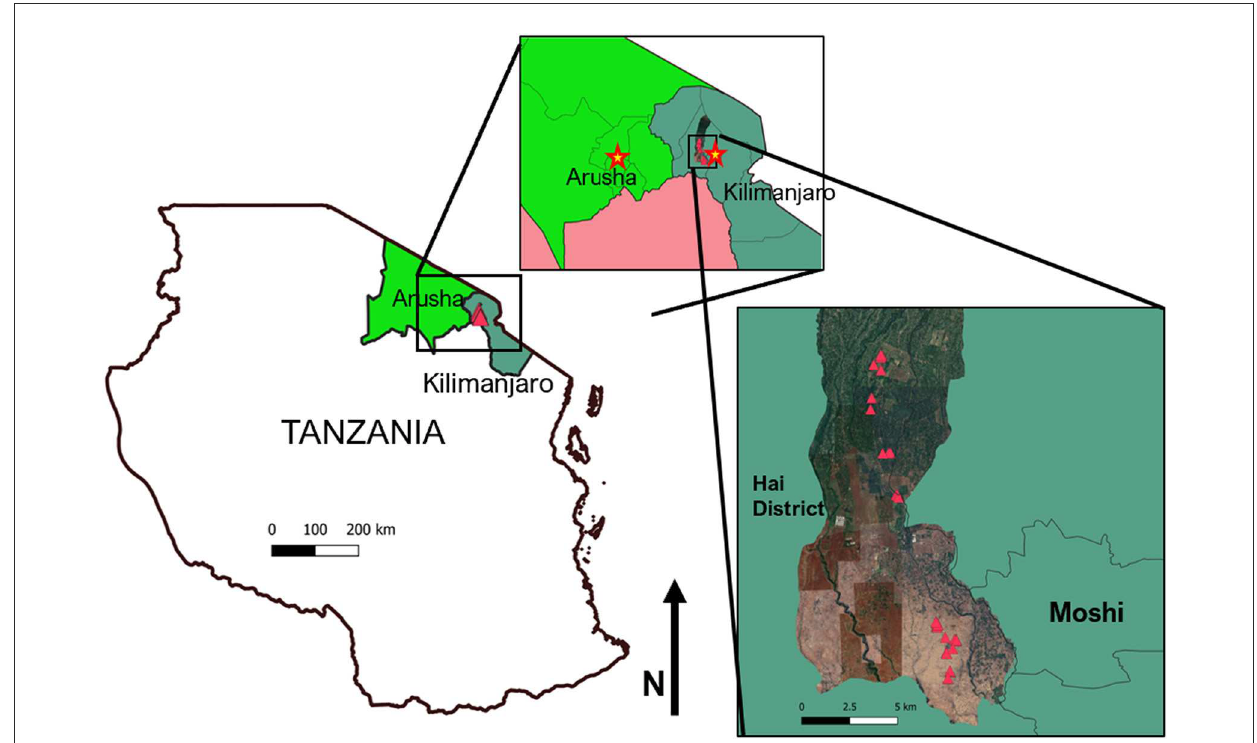
FIGURE1 Study location indicating farmers’ fields in the Hai District of the Kilimanjaro Region of northern Tanzania, where farm-level questionnaire surveys were conducted. Survey fields were arranged along an elevation gradient on the lower slopes of Mt.